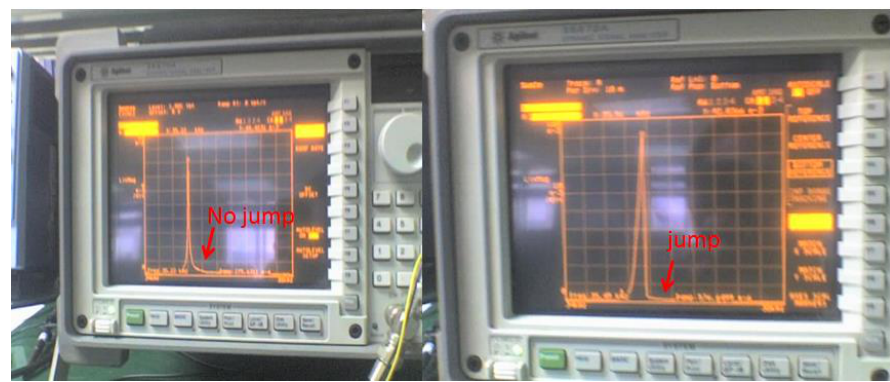
Figure 22. Nonlinear characteristics of the accelerometer.